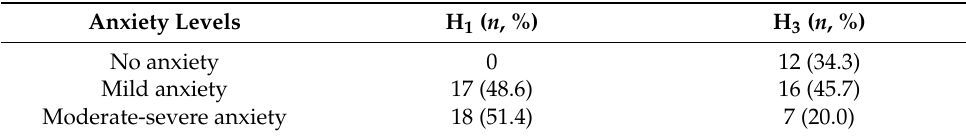
Table 2. Clinical changes in anxiety levels and well-being between baseline (H 1 ) and post-intervention (H 3 ) assessments among